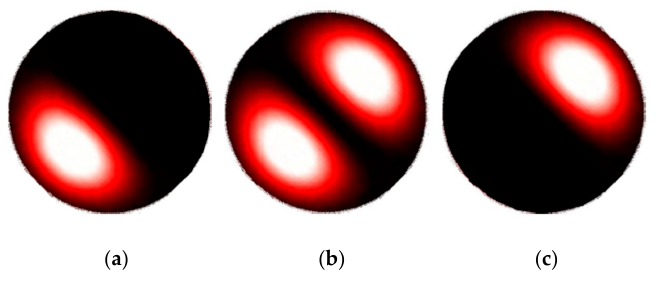
Figure 2. Rotating lobe pattern sequence ( a ), ( b ) and ( c ).